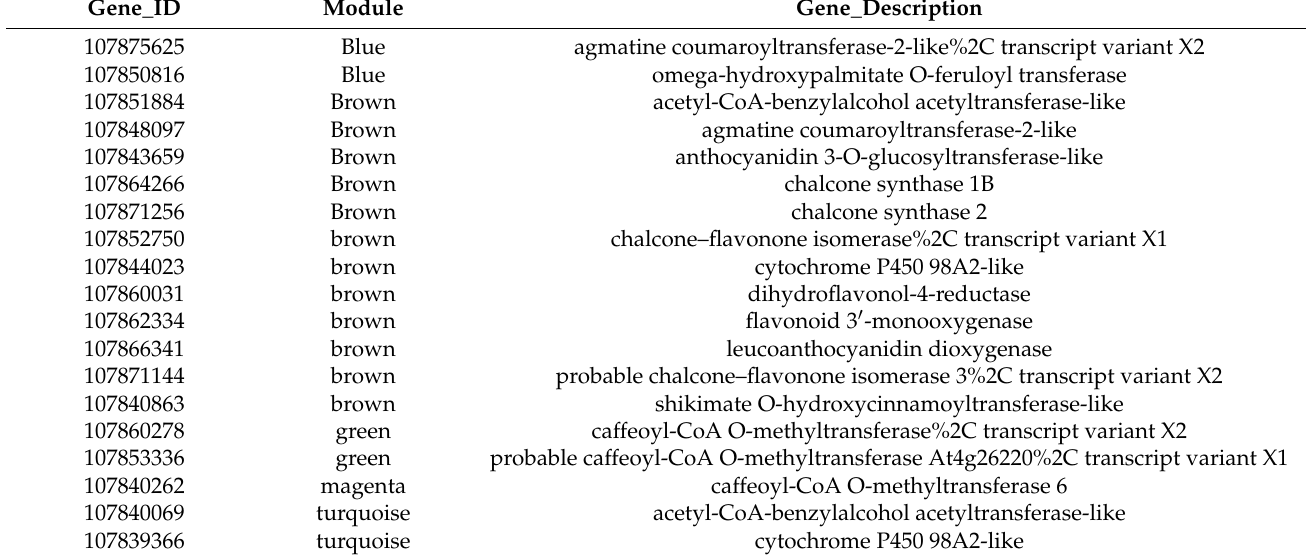
Table 4. Flavonoid biosynthesis pathway gene